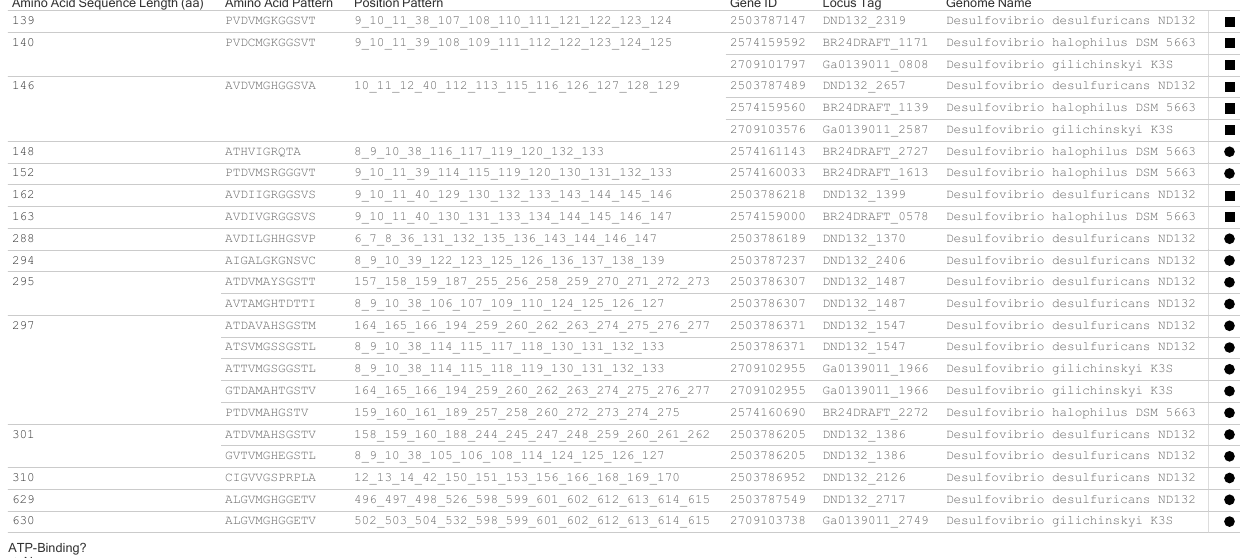
Figure 4. The patterns of amino acid type and amino acid positions for selected Desulfovibrionaceae universal stress proteins. We annotated the proteins for the presence of ATP-binding motif (filled shape, square for presence of ATP-binding motif and circle for absence of ATP-binding motif). Desulfovibrio desulfuricans ND132 and Desulfovibrio halophilus DSM 5663 are mercury methylating. Desulfovibrio gilichinskyi K3S is included for comparison of the 629 aa universal stress protein from Desulfovibrio desulfuricans ND132. Desulfovibrio desulfuricans